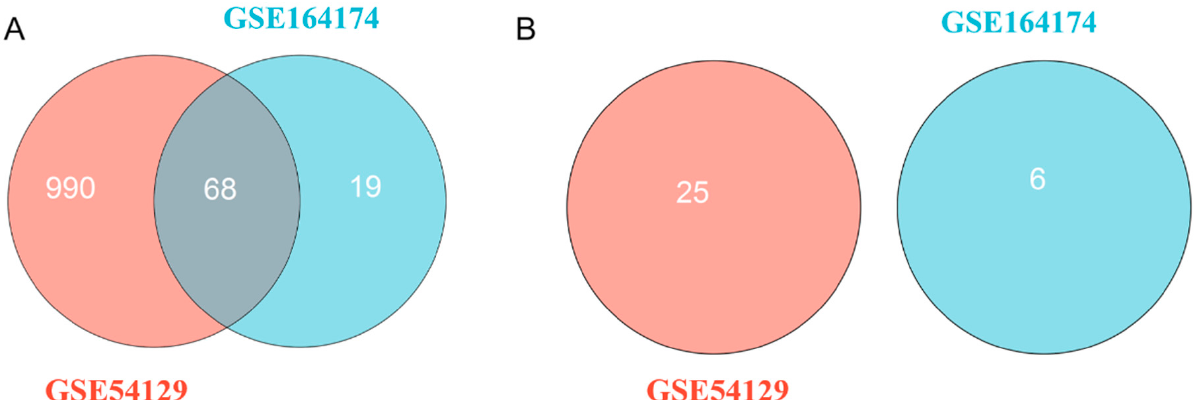
Figure 2. Venn diagram for DEmiRNAs. ( A ) A total of 68 upregulated DEmiRNAs in both the GSE54129 and GSE164174 datasets; ( B ) no DEmiRNA is downregulated commonly in both the GSE54129 and GSE164174 datasets.